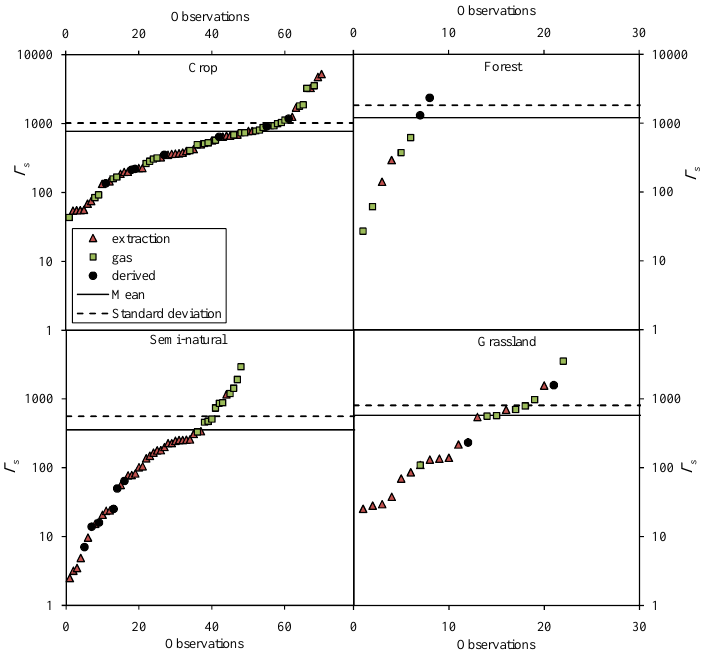
Fig. 3. Summary of stomatal ammonia emission potential ( 0 s ) from different studies (see Tables 2 and 3) as reported in the literature (means or single measurements) separated according to ecosystem type. Round symbols represent values derived from modelling, triangles represent values measured by the apoplast extraction technique and squares represent values measured by the gas exchange method. Full lines represent the mean and dashed lines the standard deviation around the mean per ecosystem type.